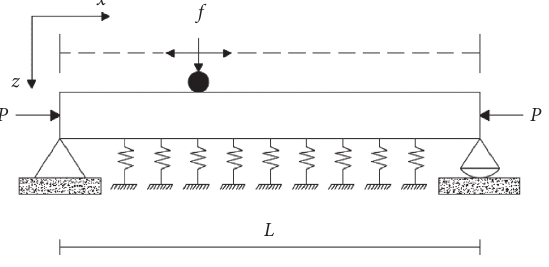
Figure 1: Physical